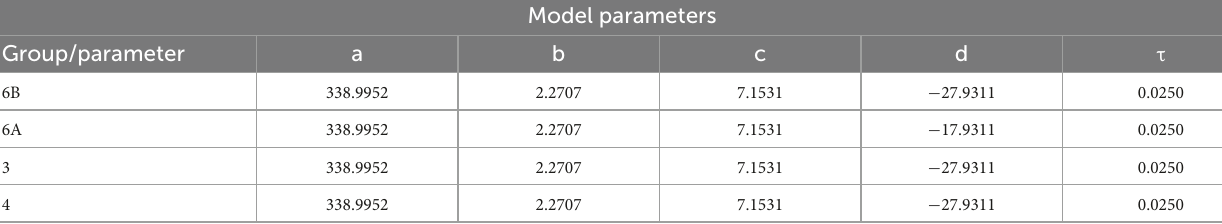
TABLE 2 CS model parameters of groups 6B, 6A, 3, and 4. Group/parameter